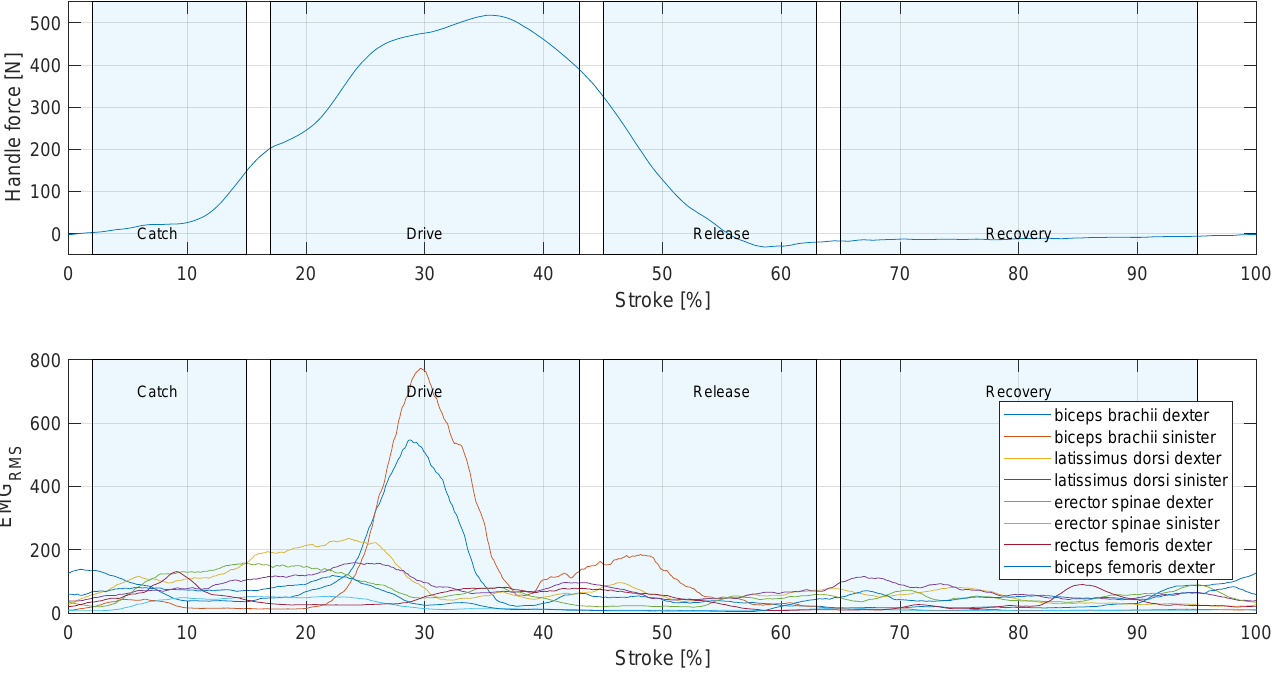
Figure 10. Activation pattern of monitored muscles during an average rowing stroke. EMG RMS : root-mean-squared EMG